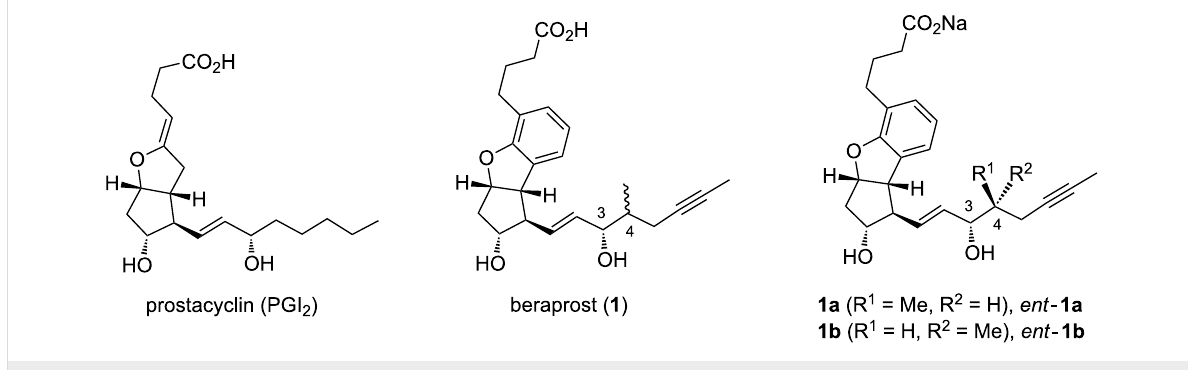
Figure 1: Structure of PGI 2 and beraprost ( 1 ).